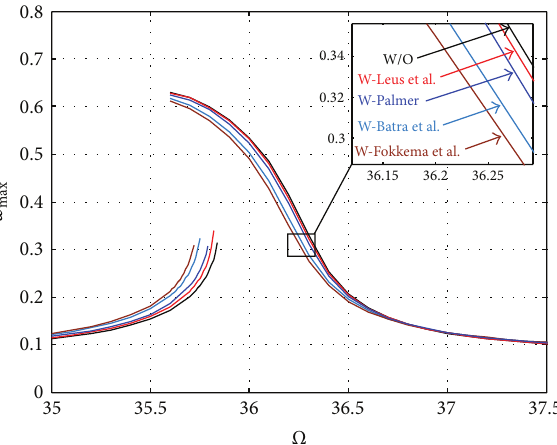
Figure 17: Frequency response curves of different fringing effect = 23 V and 𝑉 = 0.5 V (W / O means without models under 𝑉 dc ac fringing effect and W means with fringing